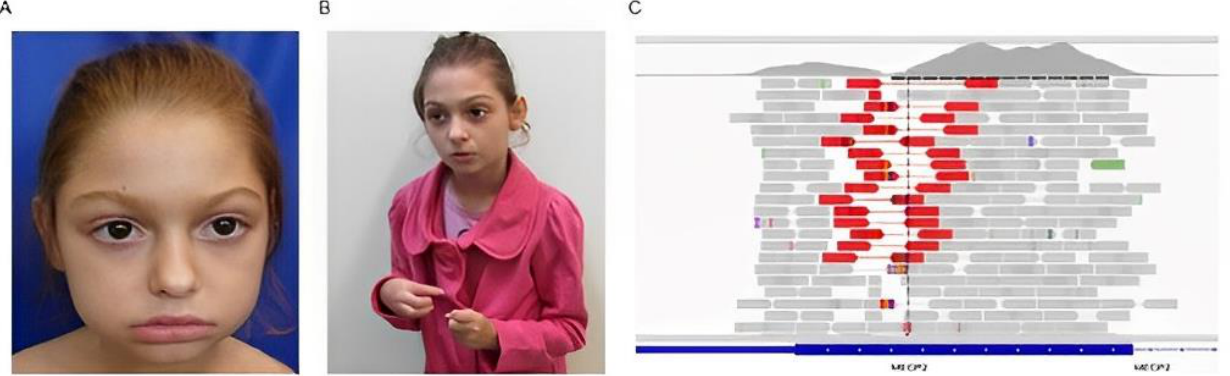
Figure 3. ( A – B ) S ubject 3 (IV-12), harboring an inherited balanced chromosomal insertion, with